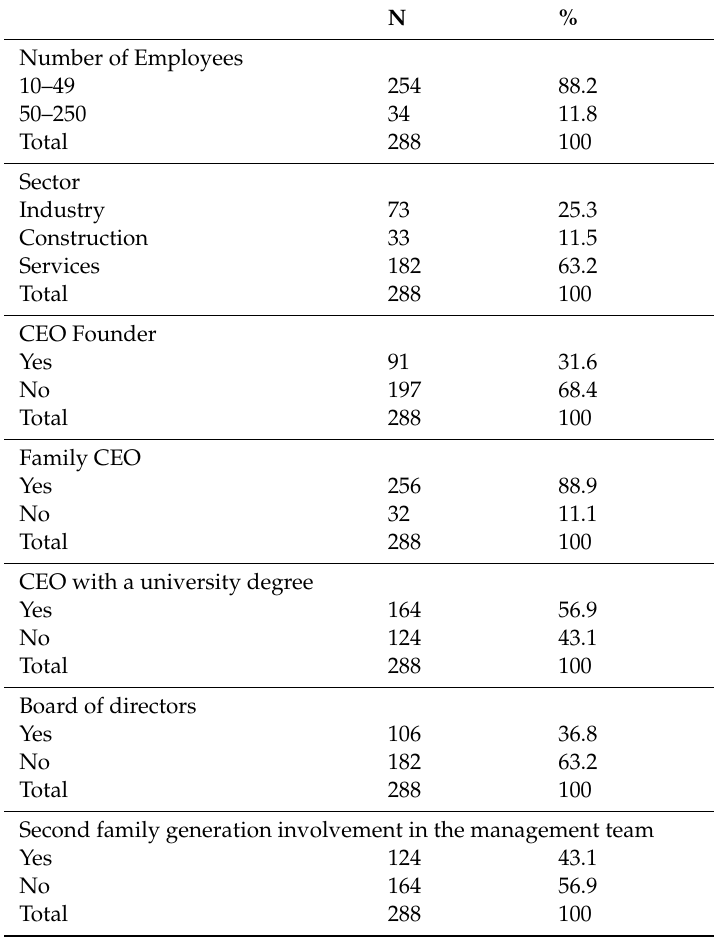
Table 1. Main characteristics of the